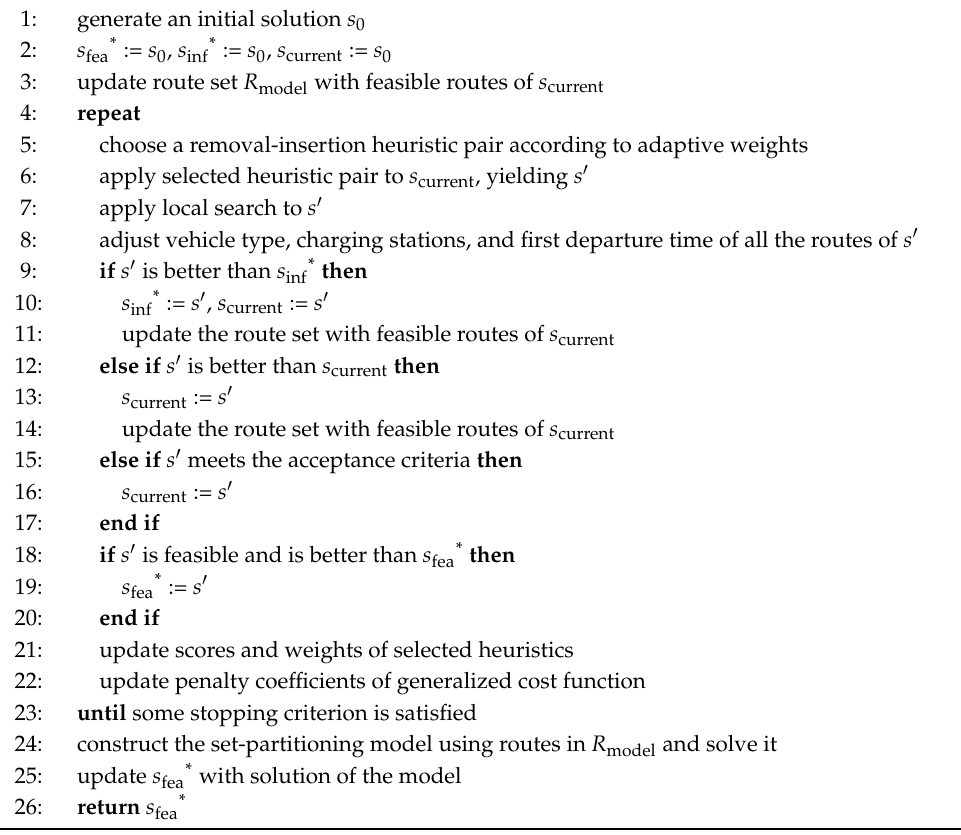
Algorithm 1: Solution approach for the proposed